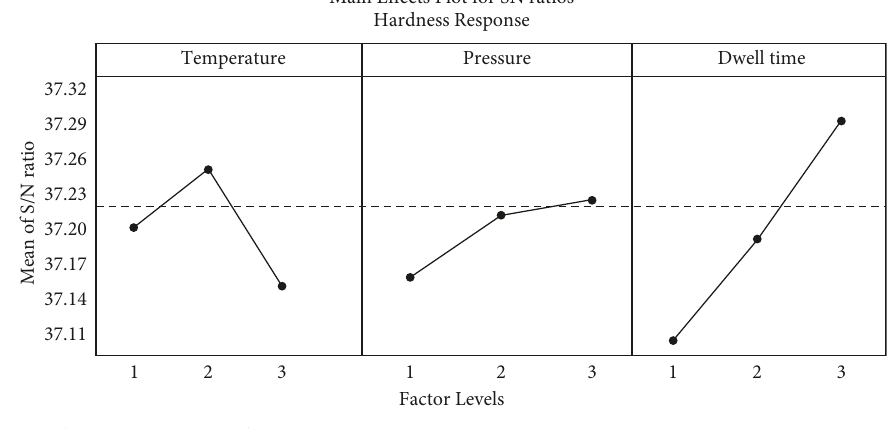
Figure 7: Main effect plot for ultimate tensile